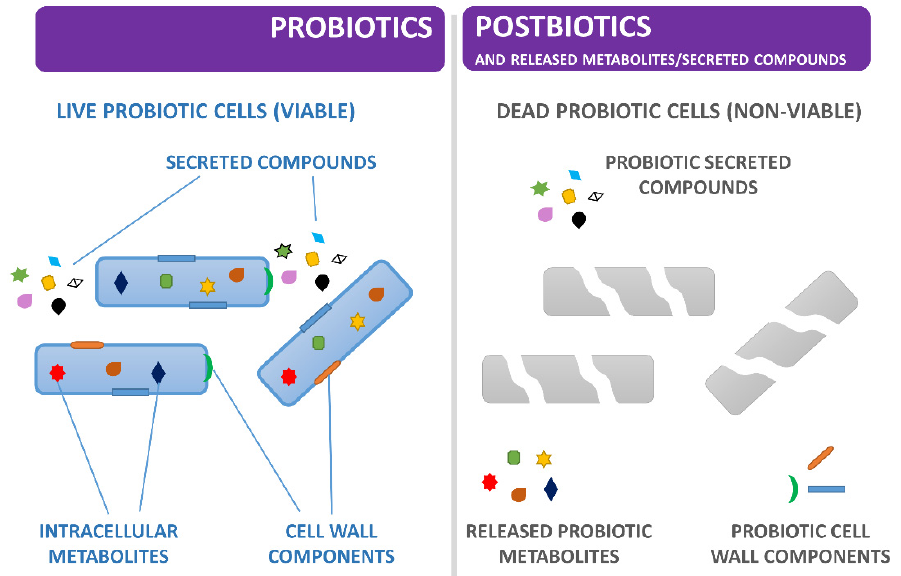
Figure 2. Graphic schematisation of the concepts of probiotic (on the left), postbiotic and released metabolites/secreted compounds (on the right). This review focuses on L. plantarum secreted compounds (i.e., CFS or isolated compounds from CFS) with antimicrobial activity.